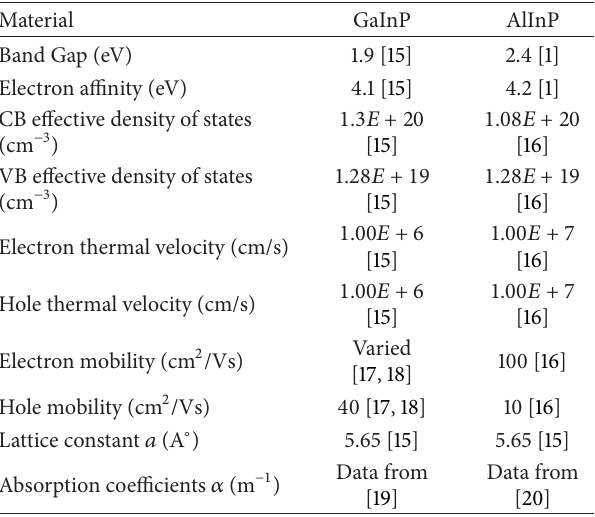
Table 2: Main material parameters used in the simulation. Table 3: The three mixed samples of PMMA doped with organic dyes used in the present